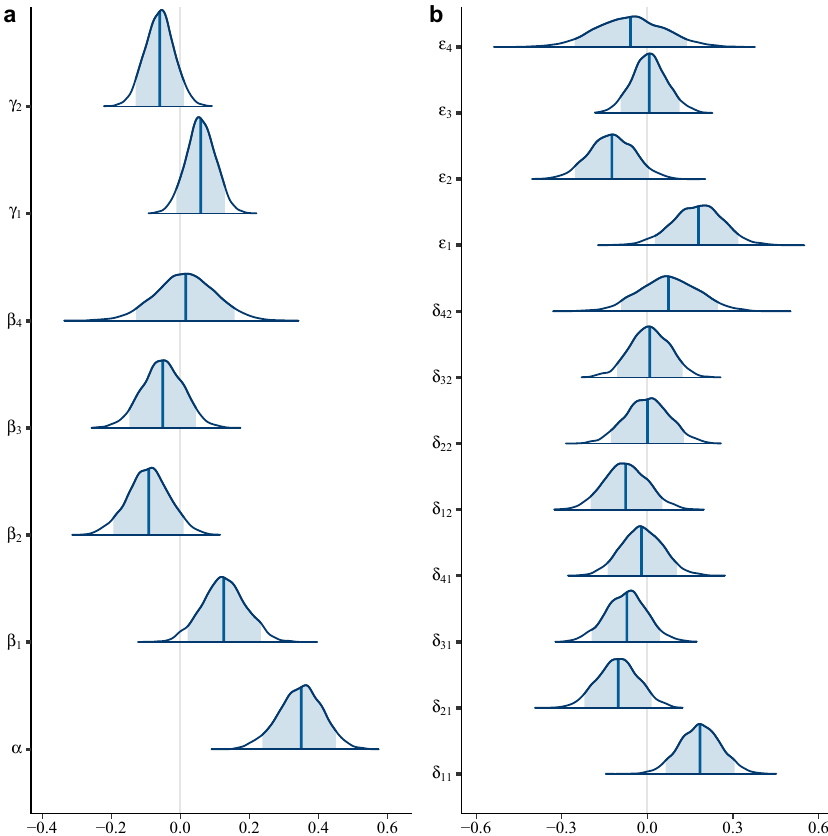
Figure 4. Inferred posterior distributions of regression parameters for all corresponding-group level predictors included in the meta-regression model. The mean and 90% credible interval (5th and 95th quantiles) are highlighted within the posteriors in blue. In panel a : α corresponds to the effect of inbreeding level of populations on ID, β is the life stage effect (1-embryonic, 2-juvenile vegetative, 3-adult vegetative, 4-adult reproductive), γ is the effect of species connectivity (1-well-connected, 2-fragmented). In panel b : δ is the effect of the interaction life stage × species connectivity, ε is the effect of the interaction inbreeding coefficient × life